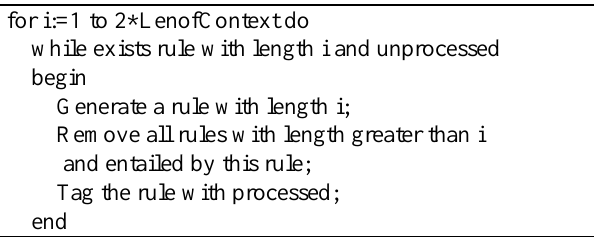
Figure 3 Pseudocode of ProduceFromStoL